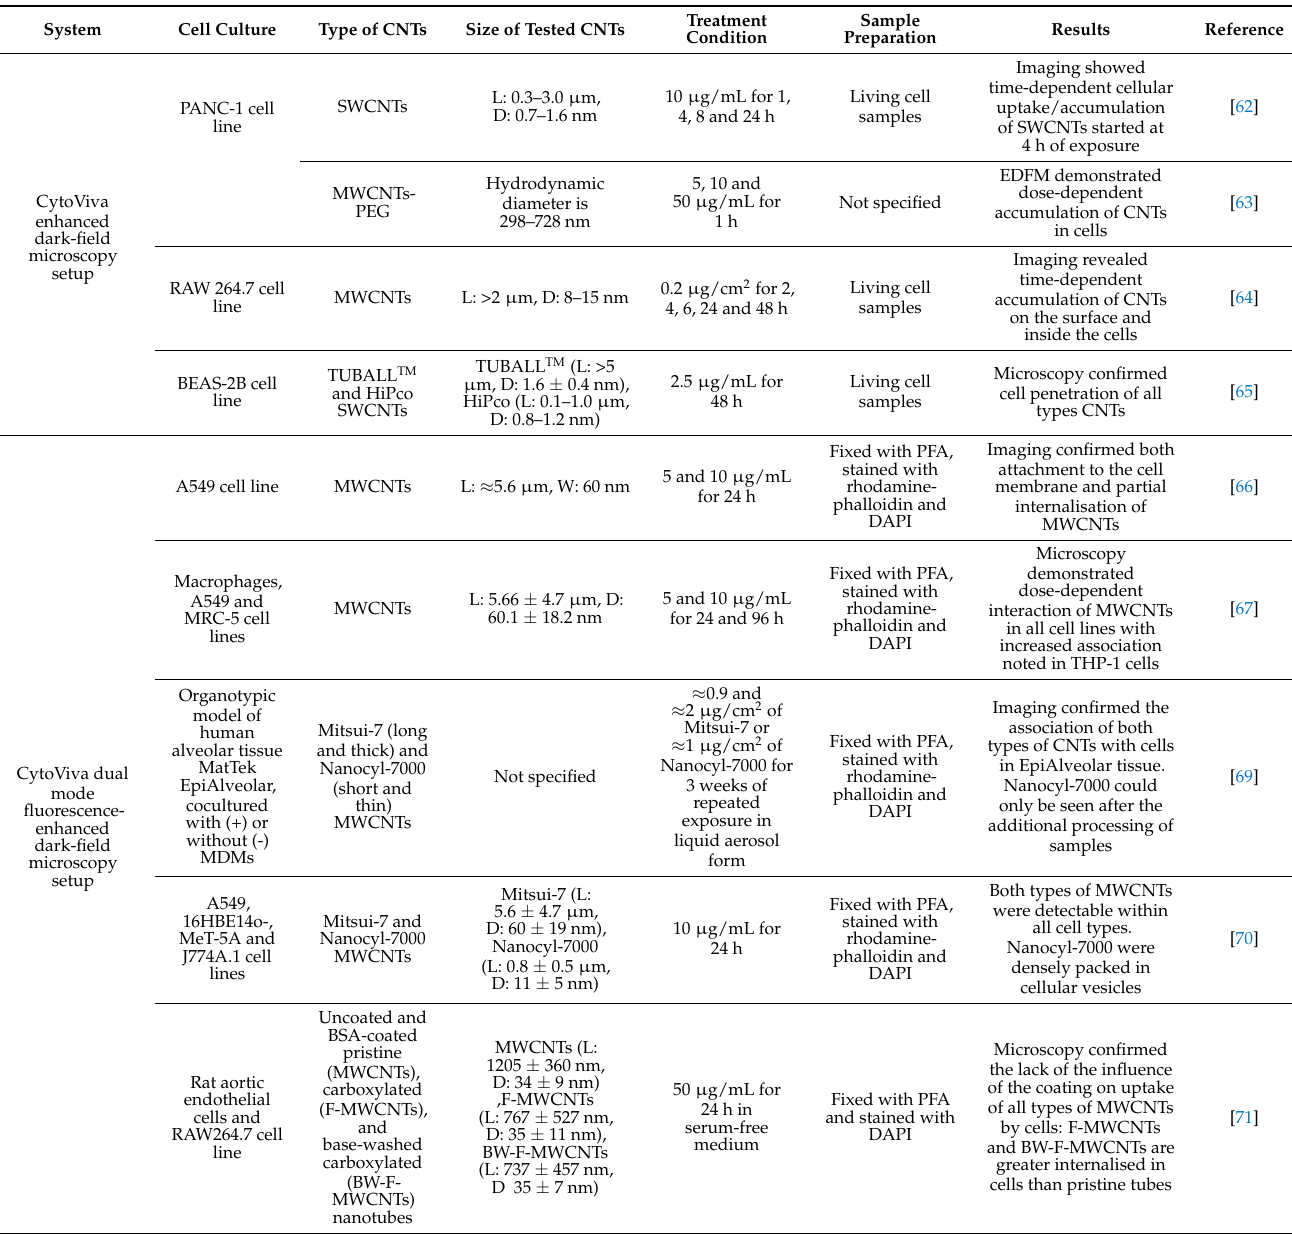
Table 1. Overview of in vitro studies of carbon nanotubes applied dark-field imaging technique. L—length; D—diameter;